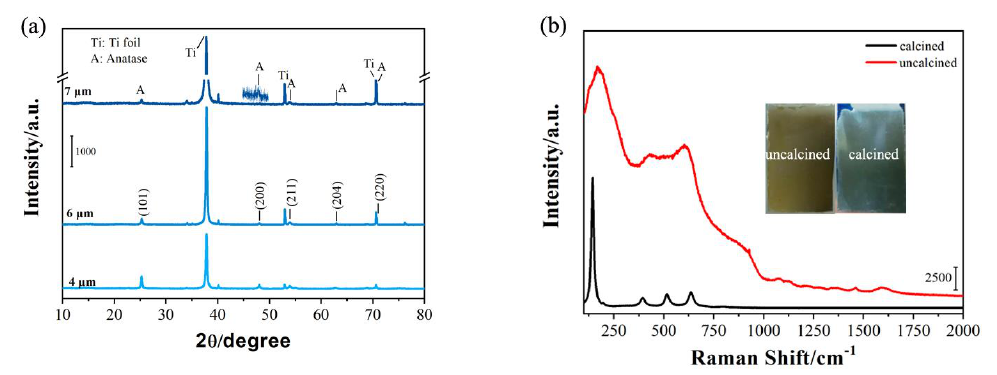
Figure 3. ( a ) X-ray diffraction patterns of TNAs with different tube lengths; ( b ) Raman spectra of uncalcined and calcined TNAs (inset: photographs of uncalcined and calcined TNAs).